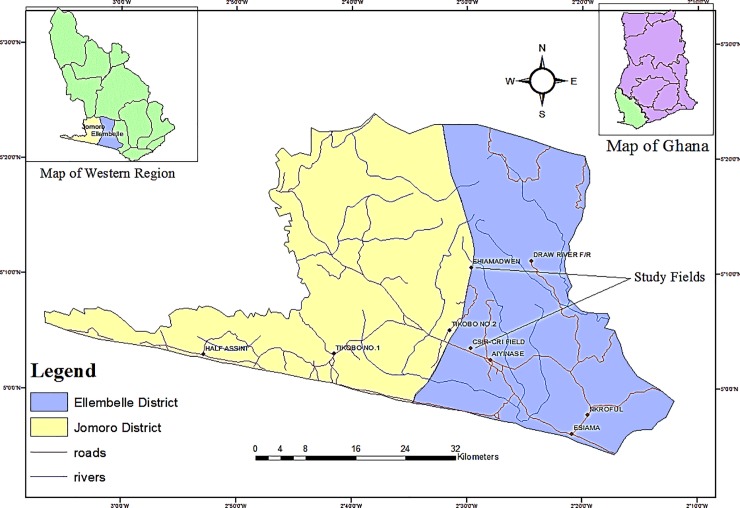
Map of Ellembelle and Jomoro districts showing the study fields.